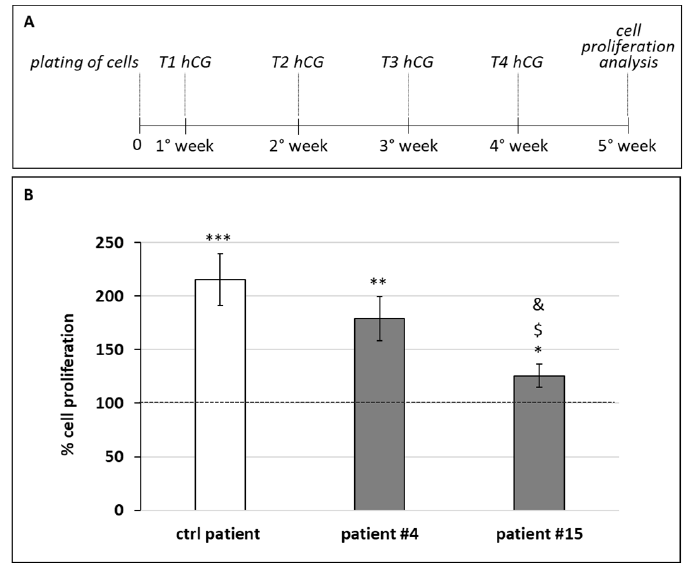
Figure 3. Effect of hCG on gubernacular cell proliferation. ( A ) Schematic representation of the treatment protocol adopted to analyze the effect of hCG on cell proliferation. ( B ) Cell proliferation of gubernacular cells cultured at 37 ◦ C with 5% CO 2 in an FBS-deprived medium treated with 100 UI/mL hCG once a week for 4 weeks. Gubernacular cells derived from a 2-year-old patient affected by cryptorchidism were used as a control. The percentage of cell proliferation was evaluated by analyzing the data of hCG treated cells for a specific patient (corresponding to the histograms) with the data obtained for the same patient cells that were not treated whose proliferation corresponded to 100% (dashed line). Cell proliferation was measured by crystal violet assay and absorbance was measured by spectrophotometric analysis (A595nm). Values are the means (±SD) of three independent biological replicates. Statistical legend: p < 0.5 (*), p < 0.01 (**), and p < 0.001 (***) for treated cells versus untreated cells of the same patient; p < 0.05 ($) for hCG treated cells of patient #15 versus hCG treated cells of control patient; p < 0.05 (&) for hCG treated cells of patient #4 versus hCG treated cells of patient #15.